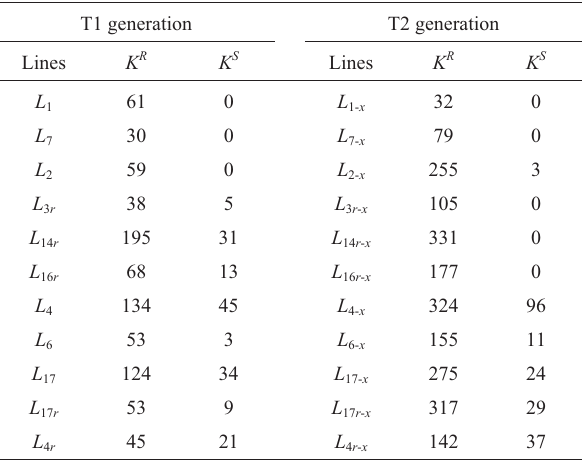
Table 4 - Kanamycin-resistance test in T1 and T2